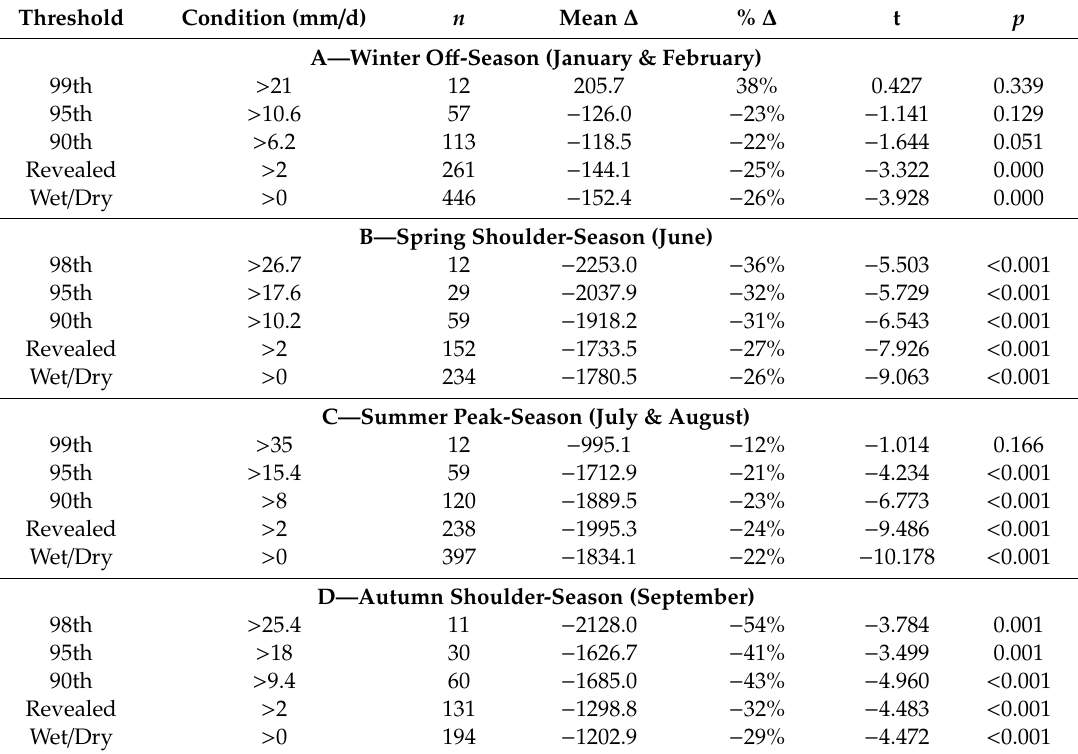
Table 4. The e ff ect of extreme precipitation on zoo attendance in Toronto, across four di ff erent